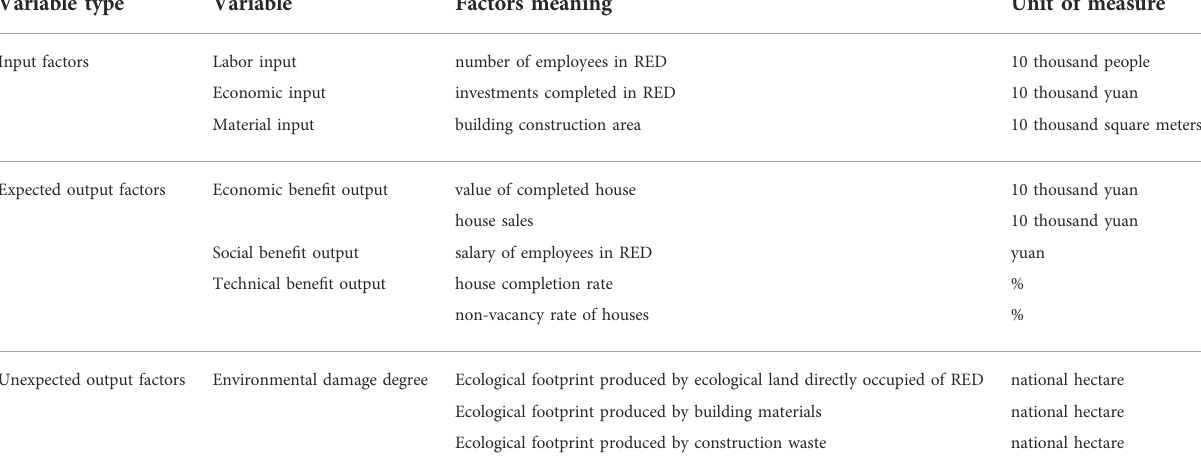
TABLE 1 Evaluation indicator system of the eco-ef fi ciency of